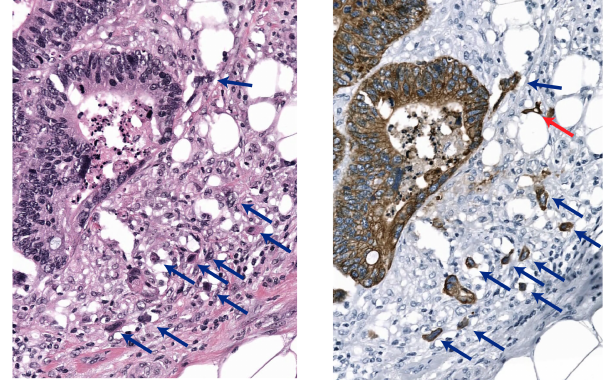
Figure 1. Tumor buds in a corresponding H&E-stained ( left ) and pan-CK stained ( right ) image from the same histology slide after destaining. Note the red arrow that shows a tumor bud that is not visible in the H&E-stained image, buds that are visible in both stains are shown by the blue